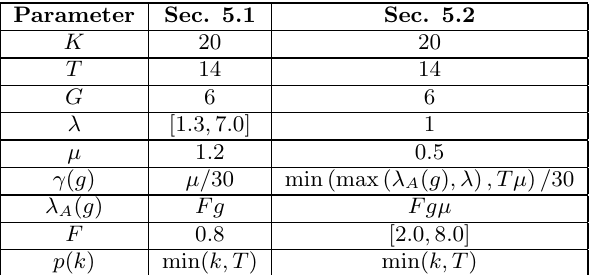
Table 1: Parameter values for the experiments of Section 5 at first chooses a request rate slightly lower (here by a factor of 0 . 8) than the service rate of a single Cloud server, which is µ . The choice for the transition rate γ ( g ) between a state